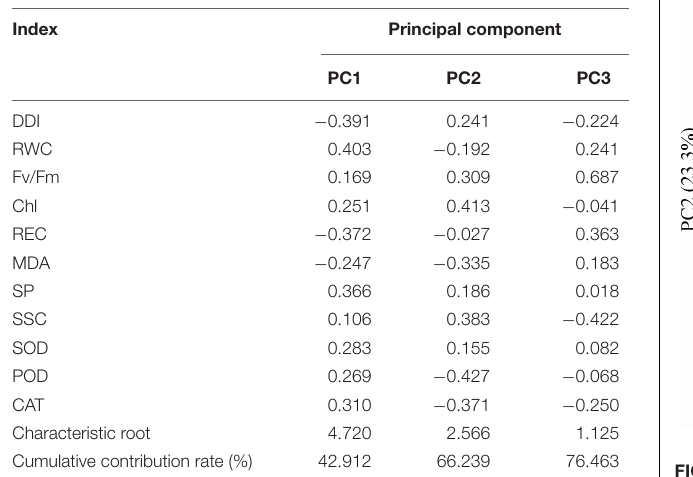
TABLE 3 | Results of principal component analysis of indexes.